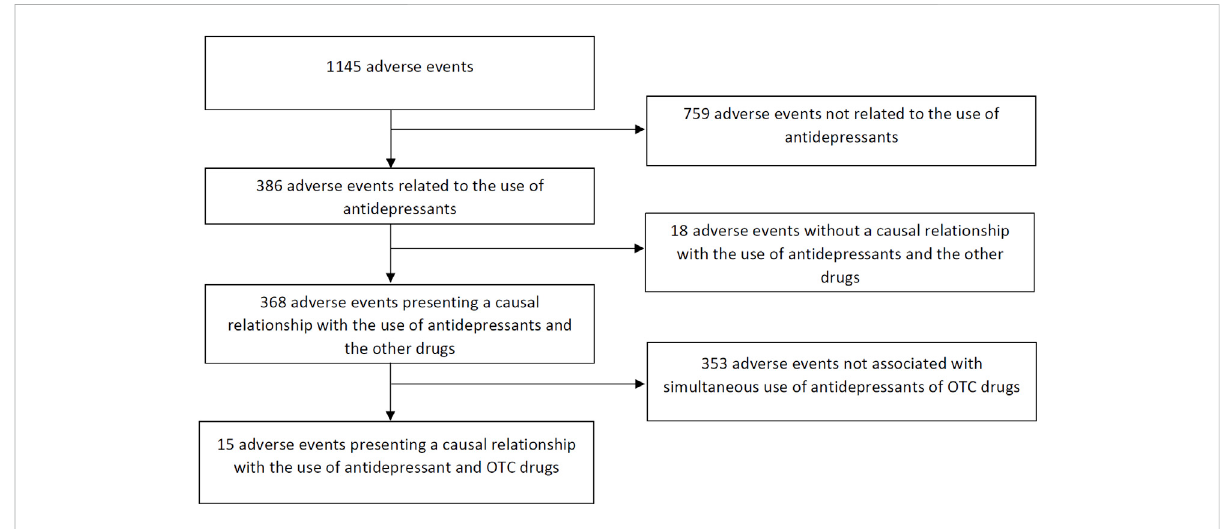
FIGURE 1 Flow chart of retrospective chart review. OTC —